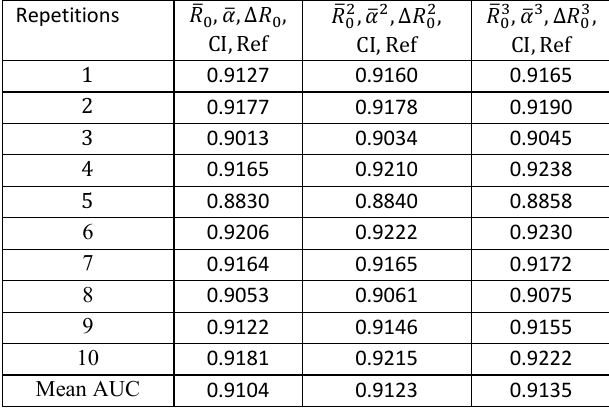
Table.3: AUC values for testing sets from 10 repeated two-fold cross validation runs with three logistic regression models